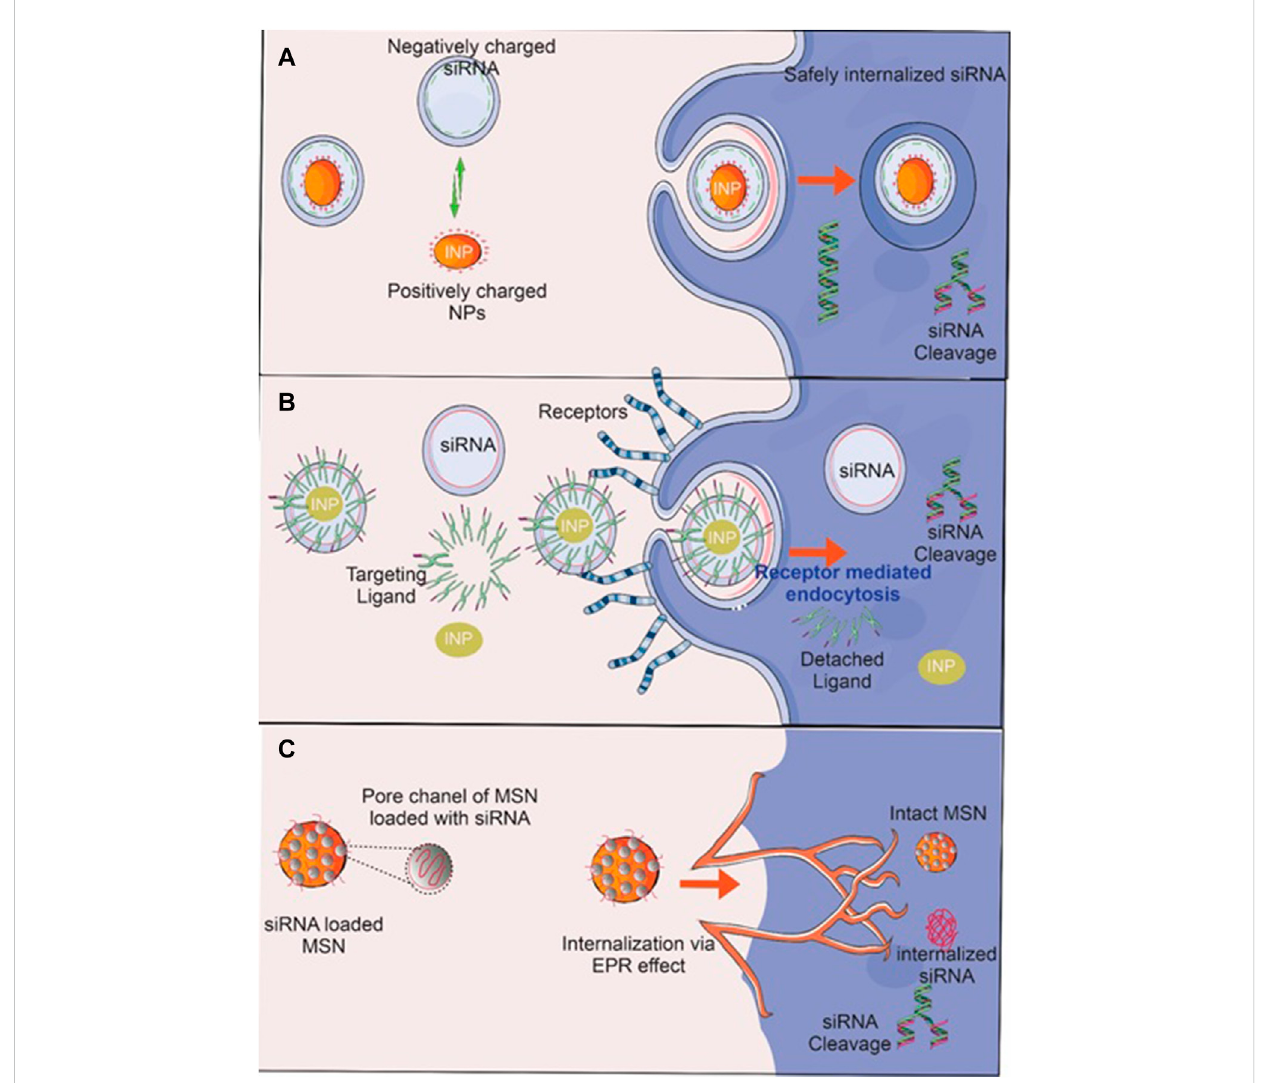
FIGURE 9 RNA delivery techniquesusing inorganic nanoparticles (INPs). Surface conjugation of INP by (A) siRNA via electrostatic attraction and (B) adsorption ofsiRNAdeliverytocancercellsandasuitableligandthattargets correspondingreceptorsoncancercellsleadstothesiRNA ’ ssafeinternalization, where itcleavesandsuppressesoncogenes. (C) siRNA-impregnatedMSNprotectssiRNAfromdegradationbyinteractingdirectly withenzymes,environmental pH, ions, and proteins, enabling its safe and ef fi cient delivery to a target site via the enhanced permeation and retention (EPR) effect, where oncogenes are then cleaved and